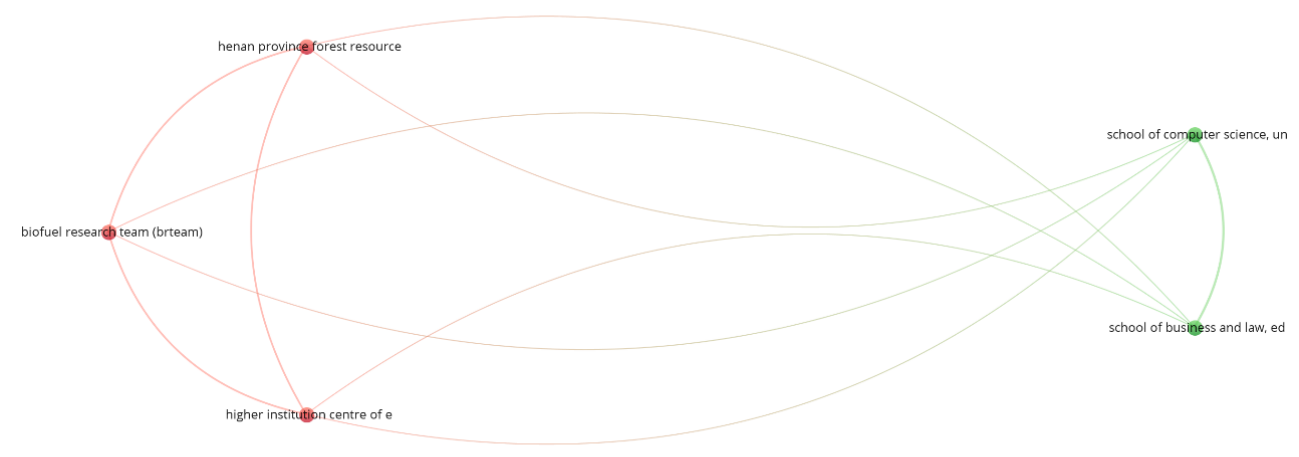
Figure 5. Network of cooperation between institutions based on the co-authorship of articles. In relation to the quality of academic institutions, the most productive countries (Table 6) are China, the United States and the United Kingdom. Spain, the fourth, receives fewer citations than Italy despite being more productive. In general, the cooperation index for countries is low except for Australia. This may indicate that the topic has been studied among researchers from the same country, but from different institutions and especially from the countries most affected by the pandemic such as China, the United States, the United Kingdom and Italy. Table 6. The ten most productive countries.